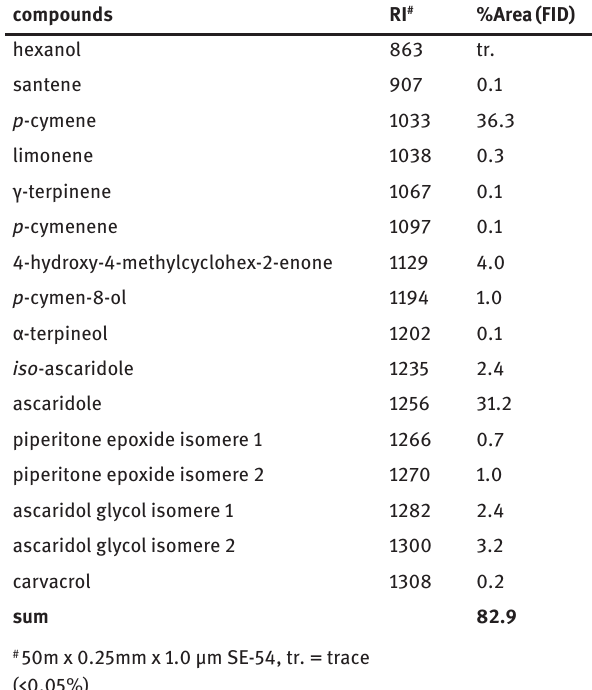
Table 3: Constituents identified in the essential oil of Dysphania ambrosioides analysed by GC-MS-FID.